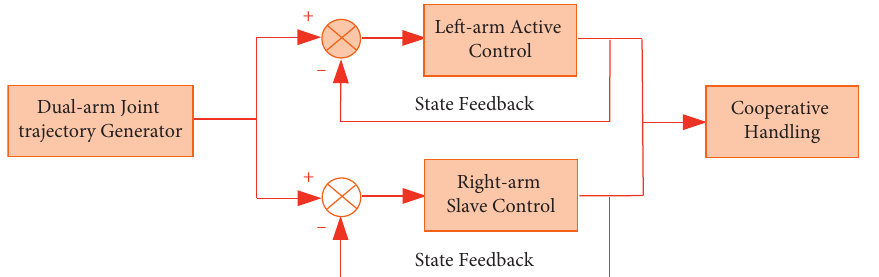
Figure 4: The control framework of dual-arm